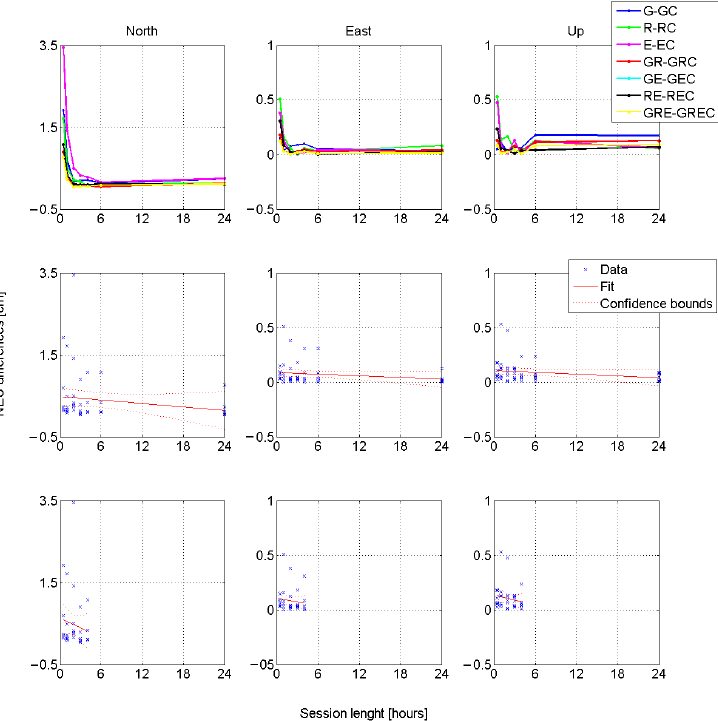
Figure 4. Improvement in NEU differences. Upper subpolts present results of comparison “true” and estimated coordinates obtained from solution without and with BeiDou observations, central subplots present linear regression plot for up to 24 h data; bottom subplots present linear regression plot for up to 4 h data (please note the different scales on vertical axis).